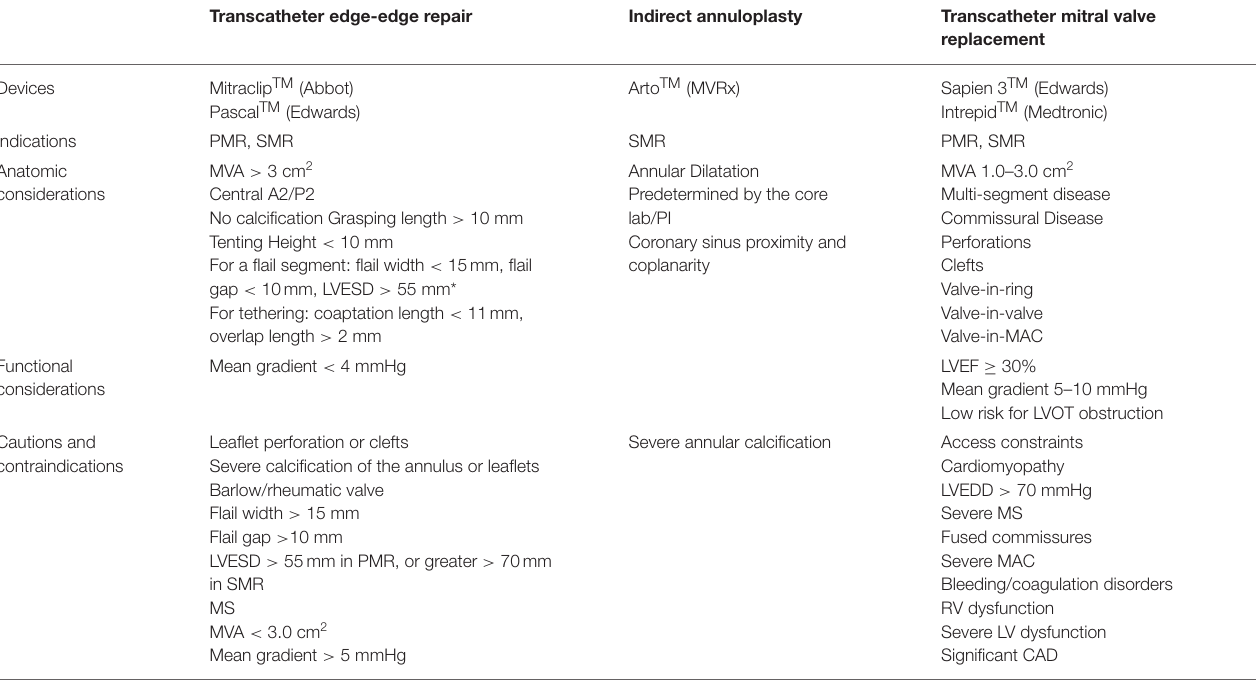
TABLE 3 | Indication and cautions for transcatheter mitral